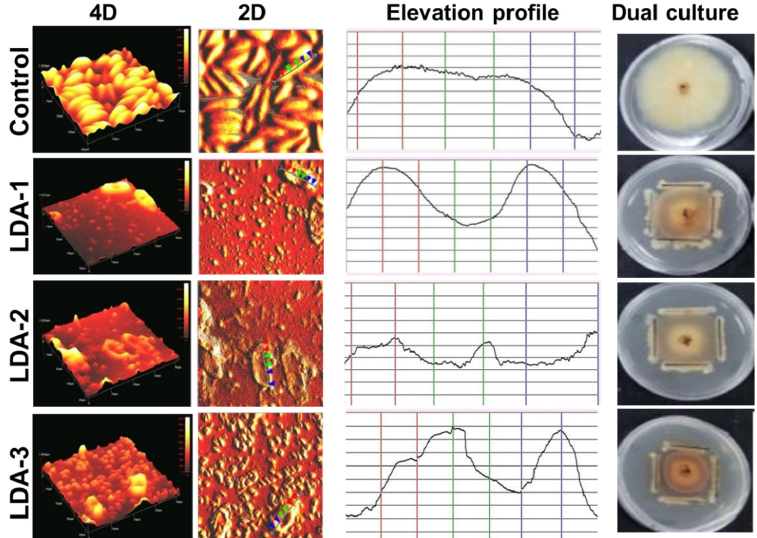
Figure 5. Atomic force microscopy (AFM) images of F. solani strain ICADL1 treated by B. subtilis strains LDA-1, LDA-2, and LDA-3 illustrating the effect of antagonistic B. subtilis strains on cell wall topography of mycelia of F. solani ICADL1. The red, green, and blue arrows of the 2D view images correspond to the points outlined in the elevation profile.